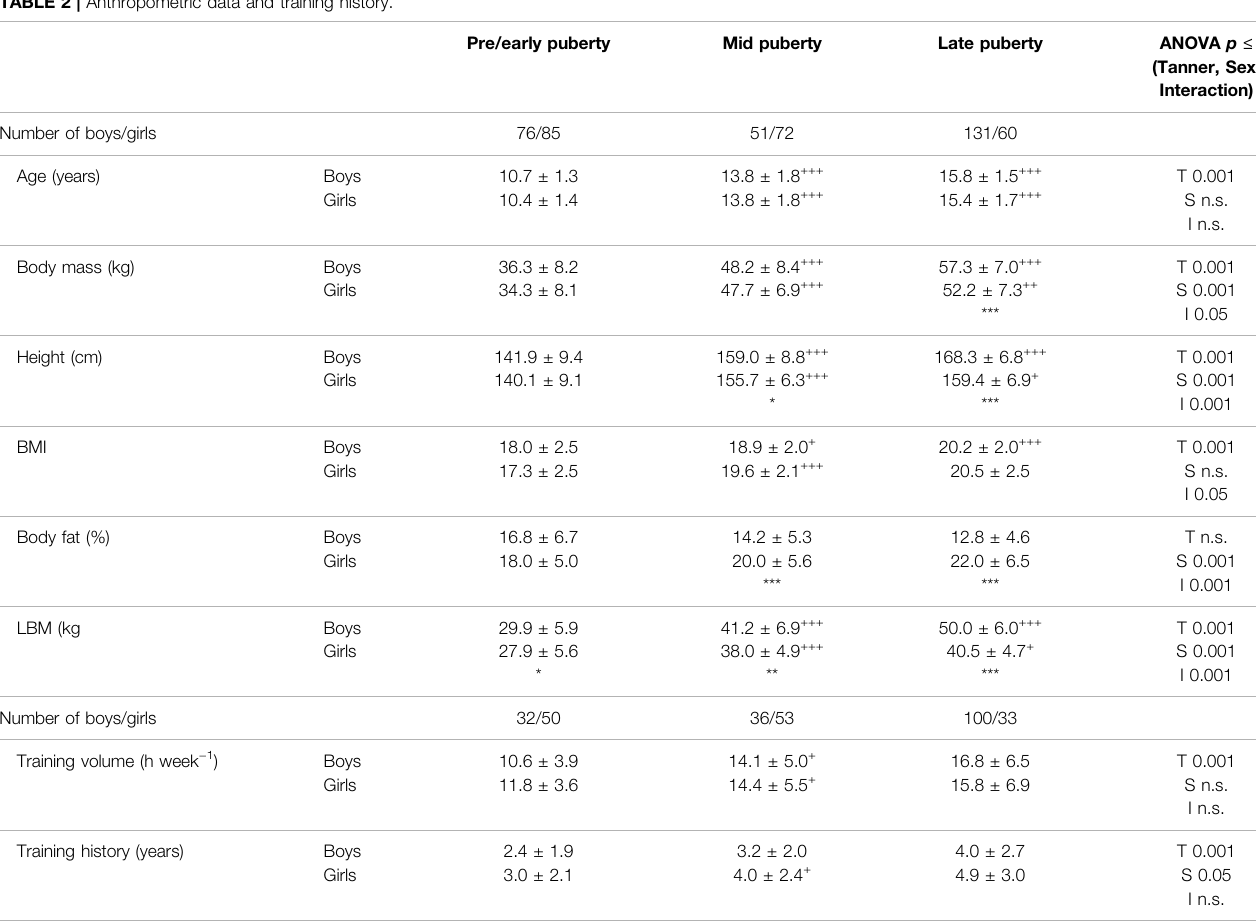
TABLE 2 | Anthropometric data and training